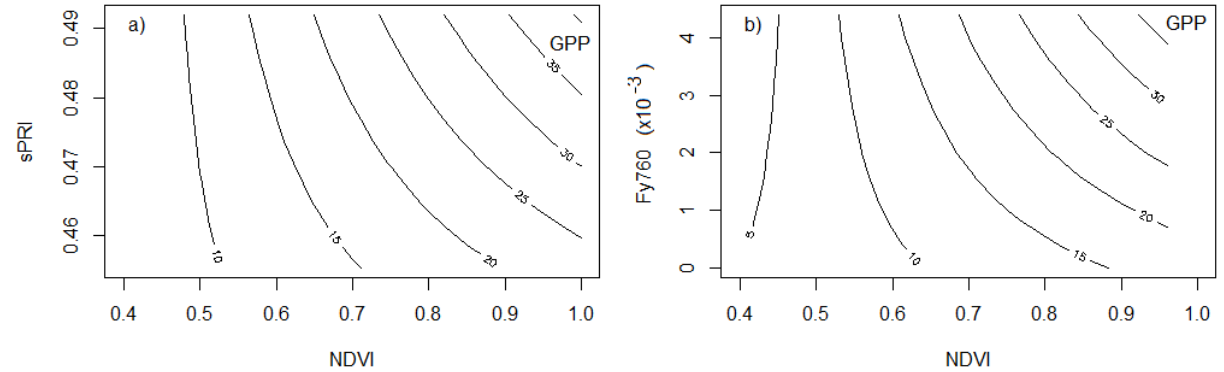
Figure 9. Contour plot indicating how variations in photosynthesis (GPP, µmol CO 2 m − 2 s − 1 ) are explained by variations in the LUE and f PAR parameters of the RSM. While (a) sPRI and (b) Fy760 are indistinctly used as a proxy of LUE, the NDVI is taken as f